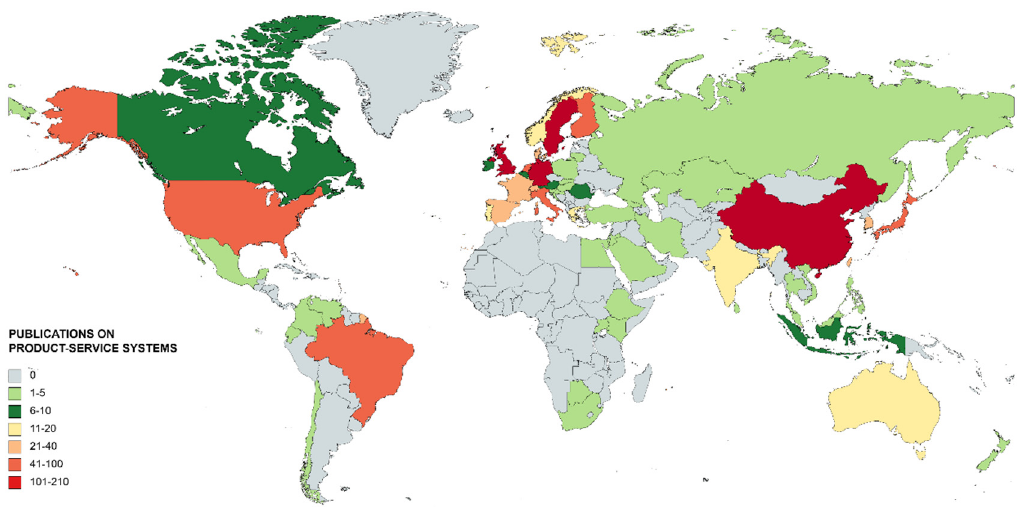
Figure 6. Worldwide publications on PSS.